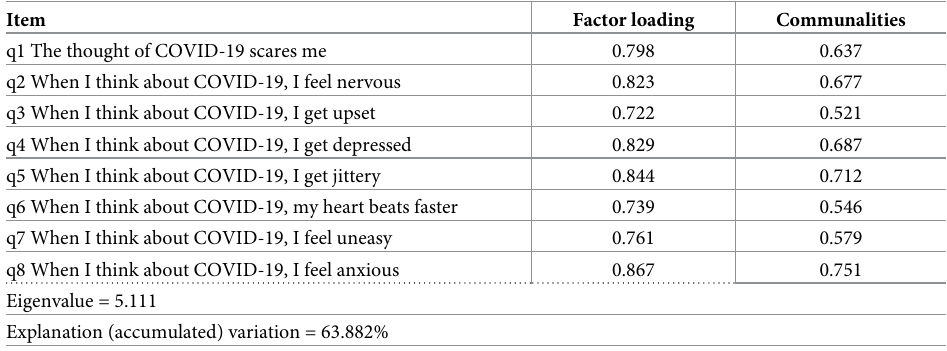
Table 4. EFA model and factor